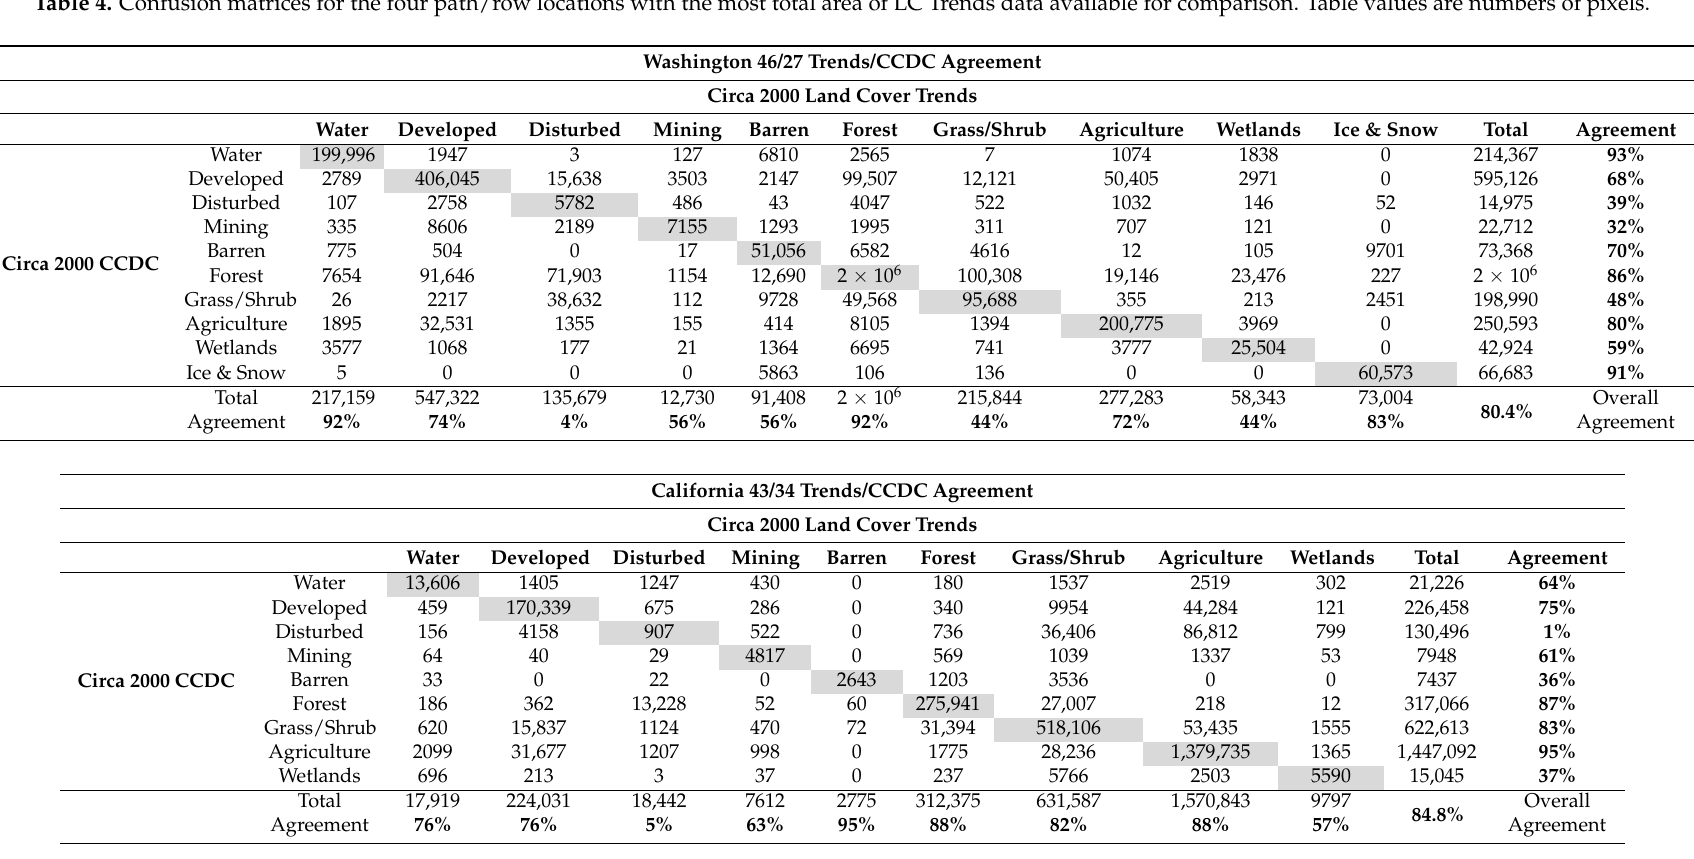
Table 4. Confusion matrices for the four path/row locations with the most total area of LC Trends data available for comparison. Table values are numbers of